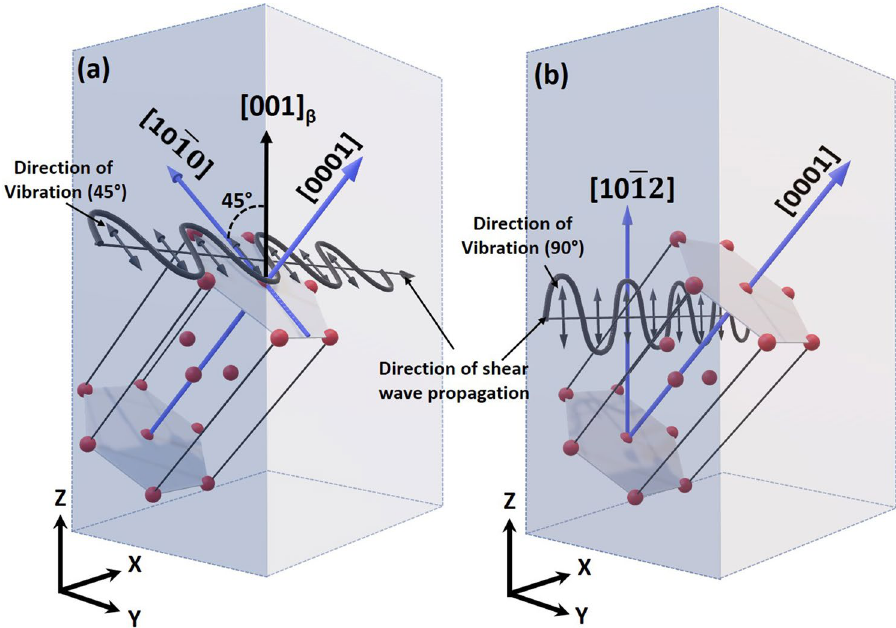
Figure 6. Schematic visualization of shear wave plane coinciding with the elastically soft direction at ( a ) 45 ◦ , ( b ) 90 ◦